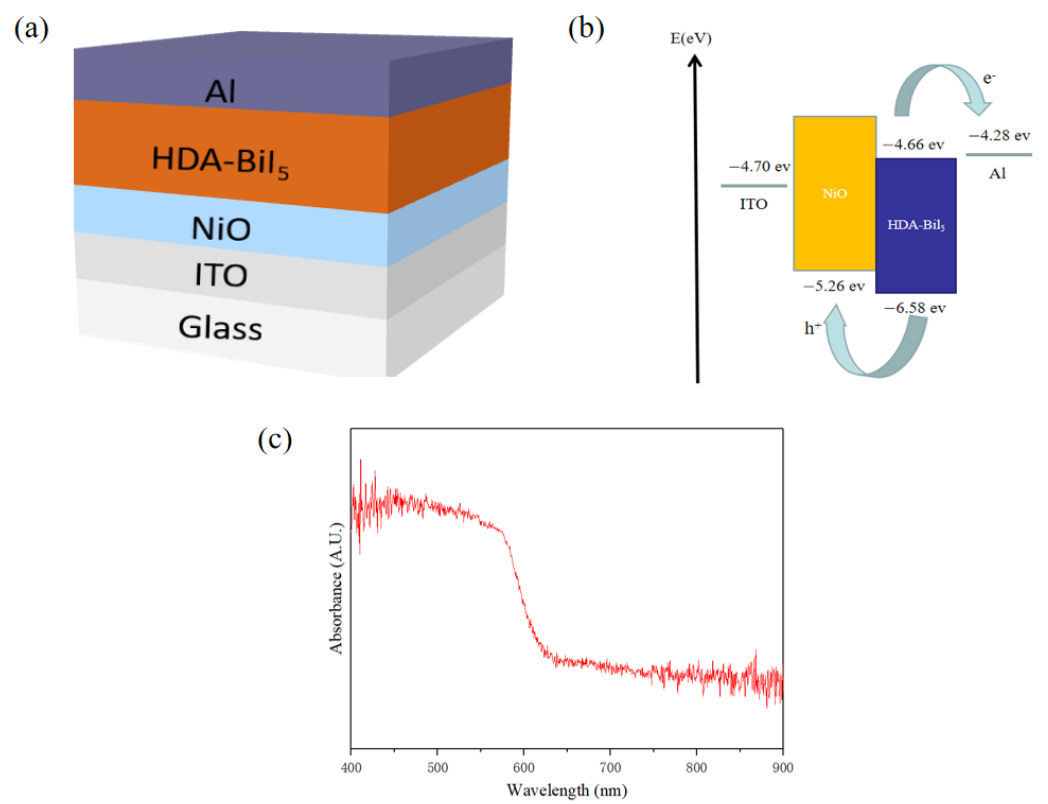
Figure 2. ( a ) Schematic diagram of the structure, ( b ) Energy band structure of each material in the ITO/NiO x /HDA-BiI 5 /Al device. ( c ) UV-vis absorption spectra.